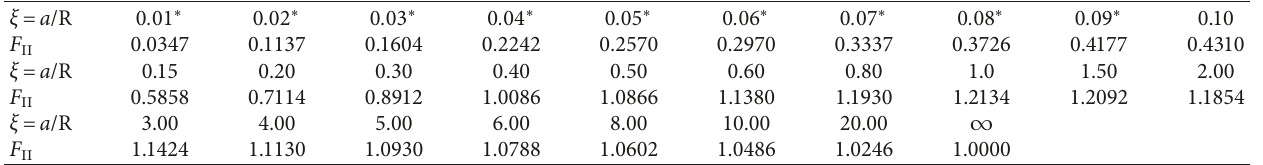
Table 1: Normalized mode-II stress intensity factor for uniform in-plane shear [22].